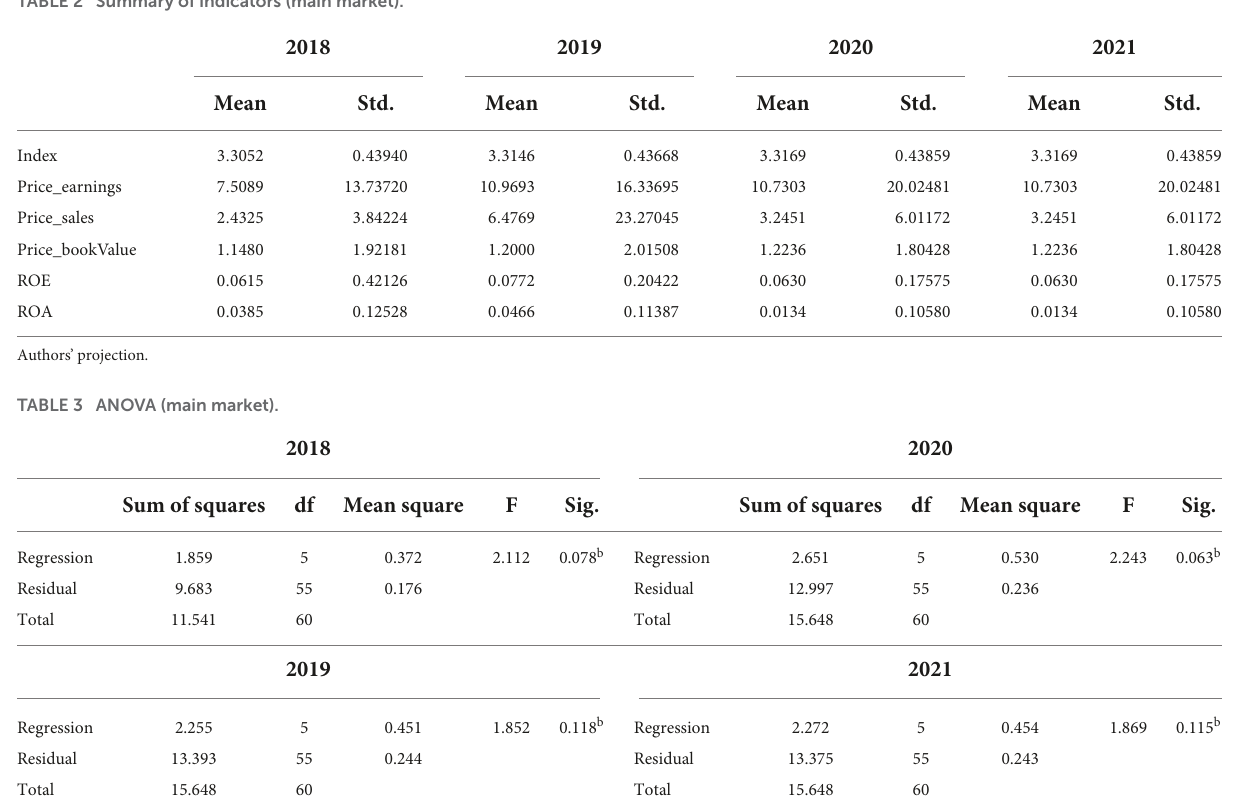
TABLE 2 Summary of indicators (main market).